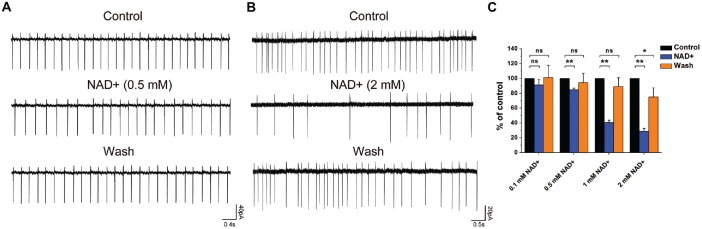
NAD+ inhibited frequency of spontaneous spikes in ventral cochlear nucleus (VCN) neurons in a dose-dependent manner. (A) Typical spontaneous spikes were recorded from a neuron in control, NAD+ (0.5 mM), and wash respectively. (B) Typical spontaneous spikes were recorded from a neuron in control, NAD+ (2 mM) and wash respectively. (C) Group results shows the effect of NAD+ in different concentrations(0.1 mM, 0.5 mM, 1 mM and 2 mM) on the normalized frequency of spontaneous activity. Error bars indicate standard deviation; *P < 0.05; **P < 0.01; ns: not significant, one-way ANOVA with Student-Newman-Keuls post hoc test.